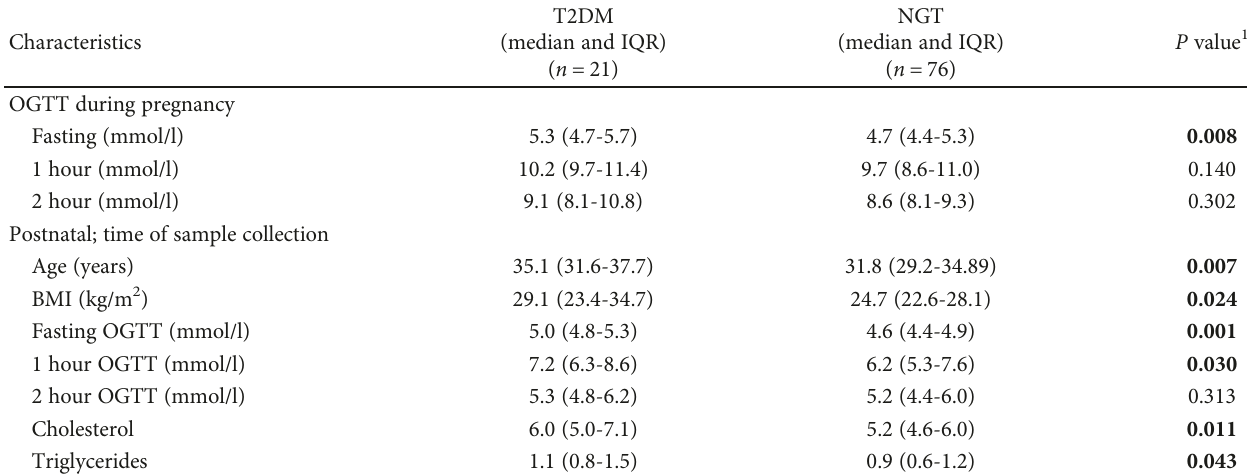
Table 1: Characteristics of the women used in this